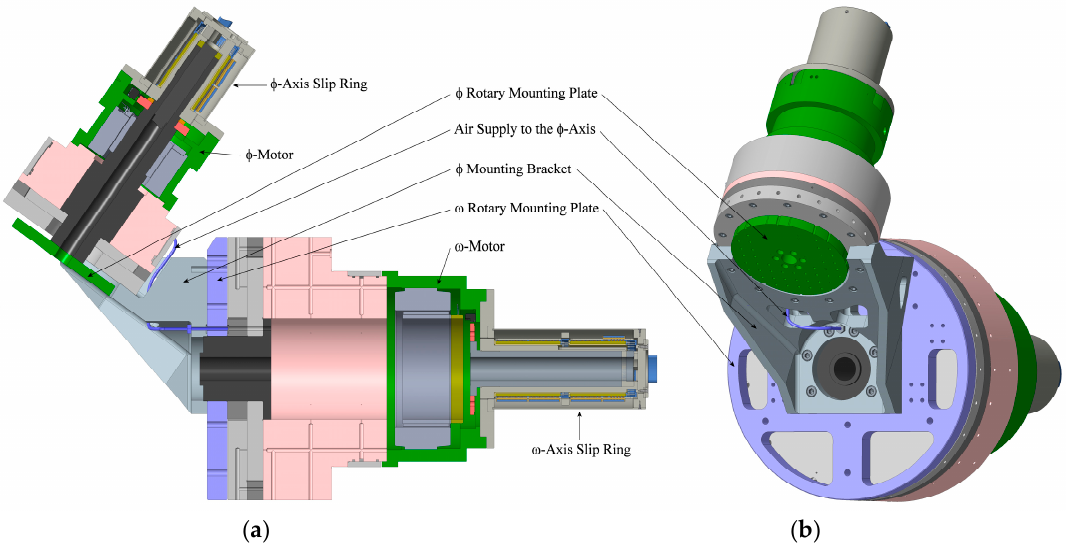
Figure 3. The dual air-bearing goniometer. ( a ) A cut-away view of the air-bearing assemblies showing the paths of the air-flows and cross-sections of both the DC-brushless motors and the electrical slip-rings. ( b ) A perspective view of the dual air-bearing goniometer detailing the ϕ -axis bracket.